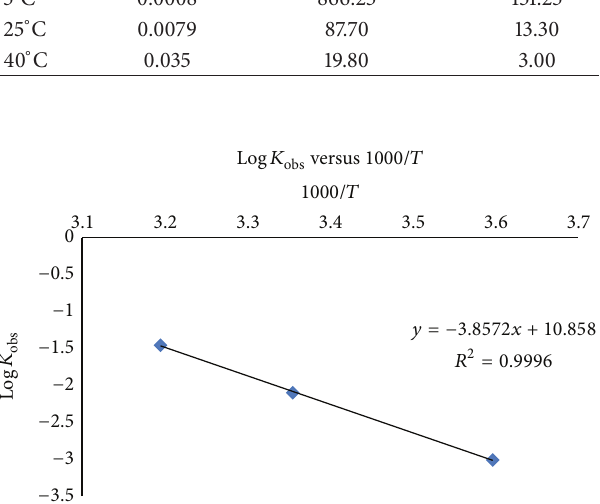
Figure 8: Arrhenius plot for degradation of colistin sulphate in phosphate buffer pH 9 and temperatures 5 ∘ , 25 ∘ , and 40 ∘